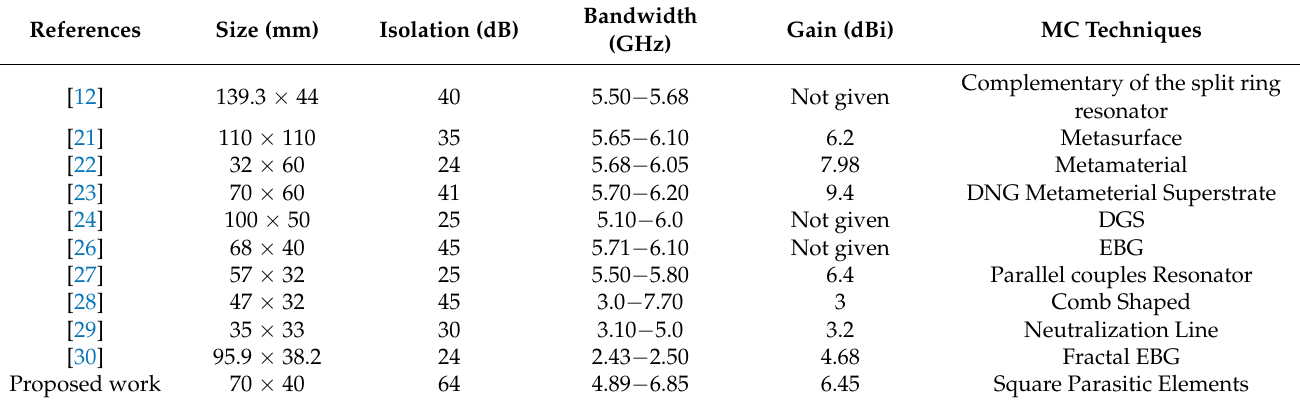
Table 2. Performance of proposed MIMO work compared with previously published